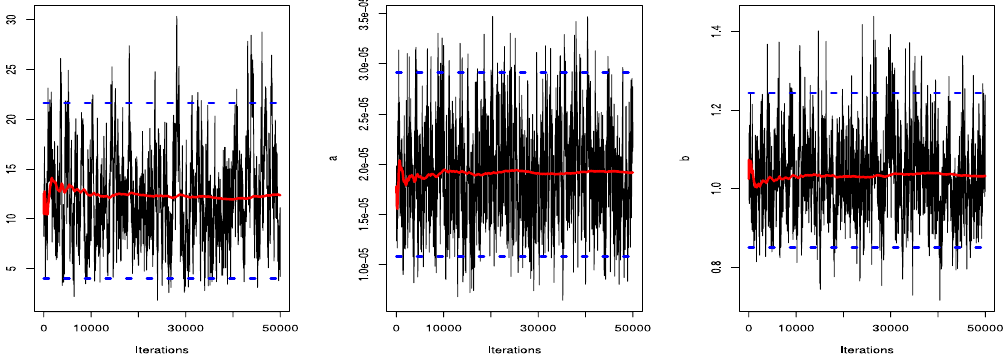
Figure 4. Iterations of MCMC results for progressive-stress model.